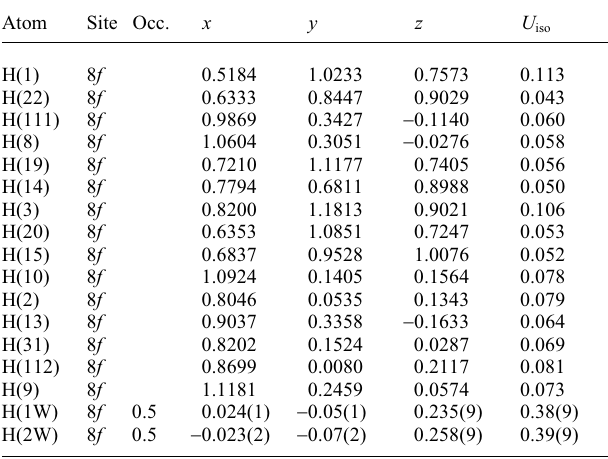
Table 2. Atomic coordinates and displacement parameters (in Å 2 ) . Atom Site